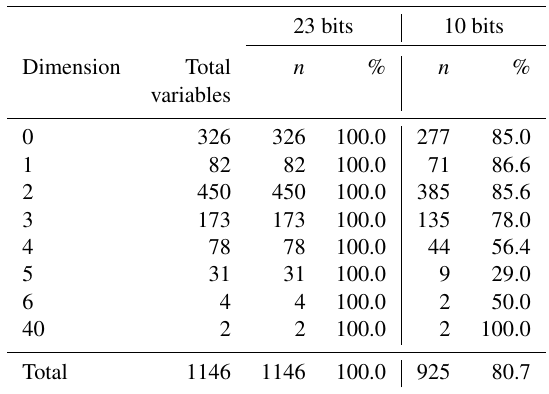
Table 4. The table presents the total number of variables that were included in the ROMS analysis split by the dimension of the arrays (0 for scalars). Also shown are the number of variables that can safely use reduced precision for the two cases discussed in Sect. 3.2 (single precision and half-precision) and the percentage of the to- tal variables that they represent. The single-precision case was triv- ial since all the variables considered can use single precision while keeping the accuracy. For the half-precision case, 80.7% of the vari- ables could use half-precision, although the proportion of variables that can use reduced precision becomes lower as the dimension in-